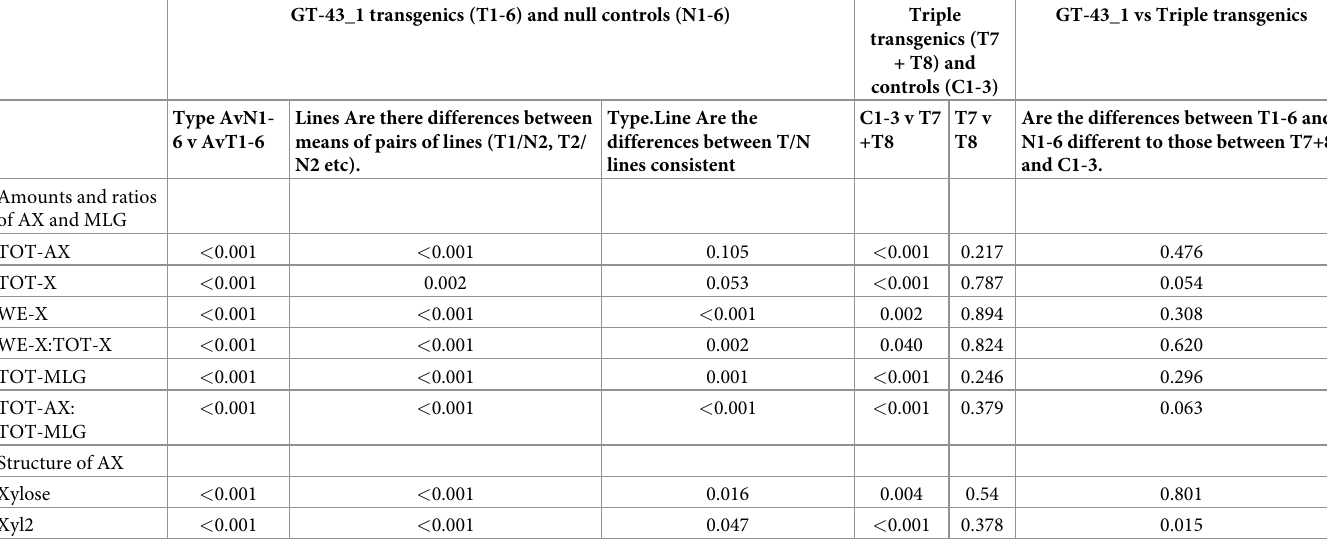
the T and N lines which were consistent between pairs. However, differences between the 6 pairs were also observed, demonstrating the importance of comparing transgenic lines with null controls. ANOVA of the averages of the two triple transgenic lines (T7, T8) and the averages of these lines to the average of the controls (C1-3) (Table 3 and S6 Table) showed no significant differ- ences between T7 and T8, but that these lines differed significantly from C1-3 in the amounts of AX, MLG as well as the ratio WE-X:TOT-X (P = 0.040). Analysis of AX structure by fingerprinting showed differences between the T and N lines, with greater decreases in the amounts of substituted AXOS compared to xylan fragments derived only from the xylan backbone (Xyl 1, 2, 3 and 5) (S7 Table). These differences were sta- tistically significant between types of lines (T and N) for all AXOS except XA3XA3XX and there were significant differences between the six between pairs of lines for all AXOS except XA3XA2+3XX (Table 3 and S8 Table). These effects are illustrated in Fig 1, with the peak areas Table 3. Probabilities (p) from ANOVA of differences in amounts, ratios, and compositions of AX and MLG in transgenic and control lines. Transformed data (log or sq. root) were used for some data as detailed in S4 Table.